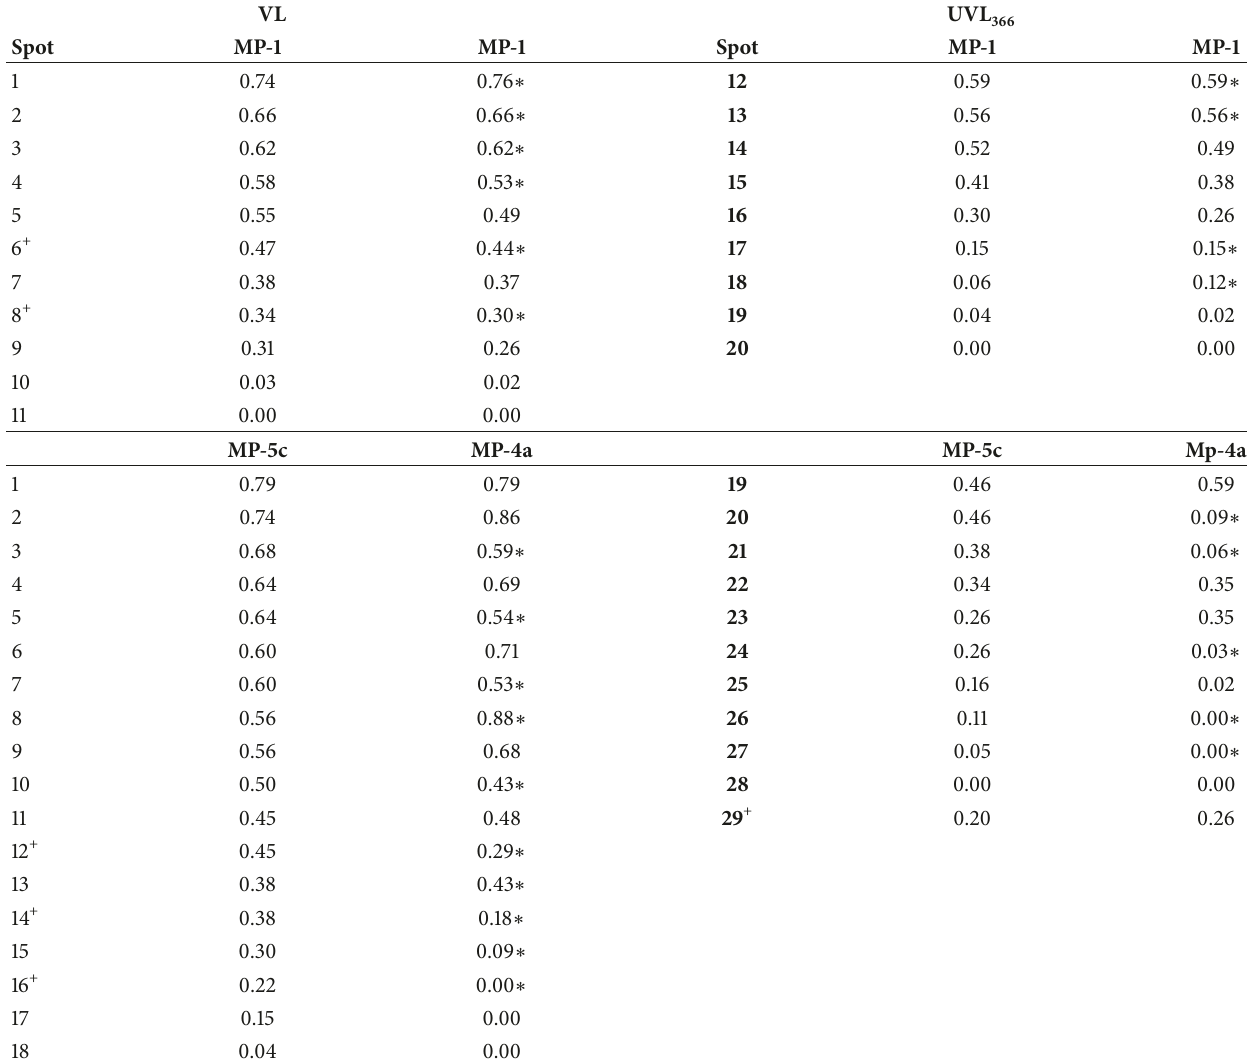
Table 3: Retention factor (R F ) values observed in 2D-TLC plates, developed with the indicated mobile